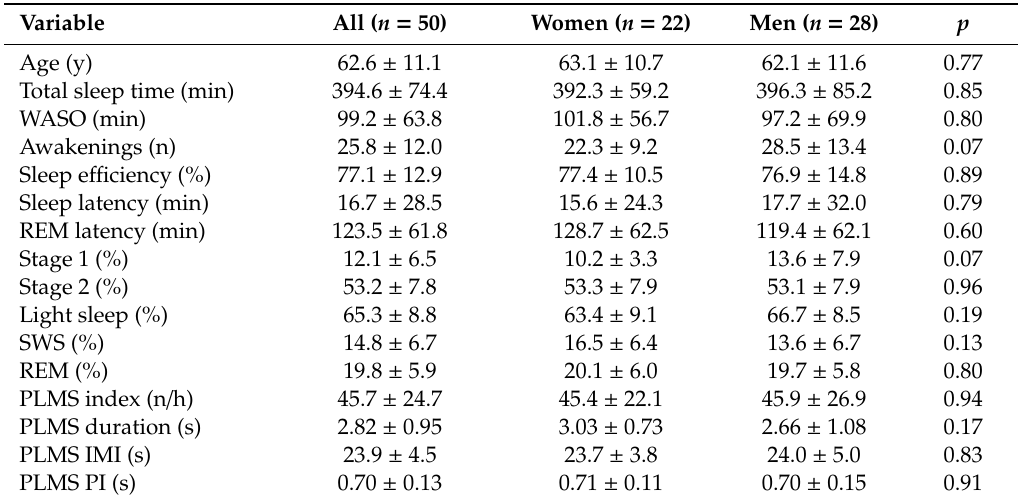
Table 1. Clinical and sleep data for all subjects and according to sex (means ± SD).